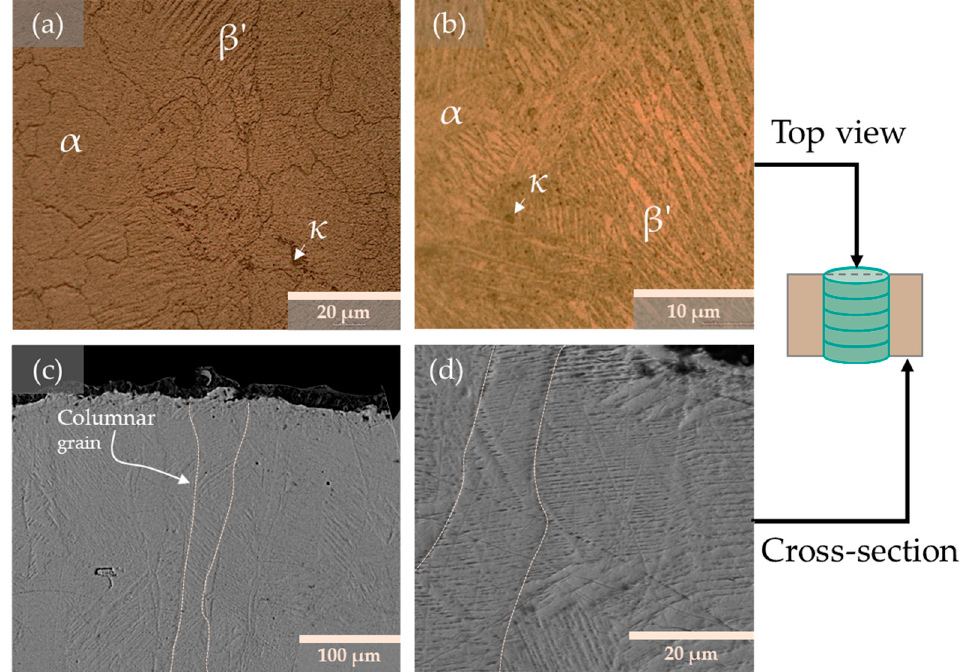
Figure 4. Microstructure of sample fabricated vertically with 125 J · mm − 3 ( a , b ) Optical microscopy images of the top view and ( c , d ) FE-SEM micrographs of the